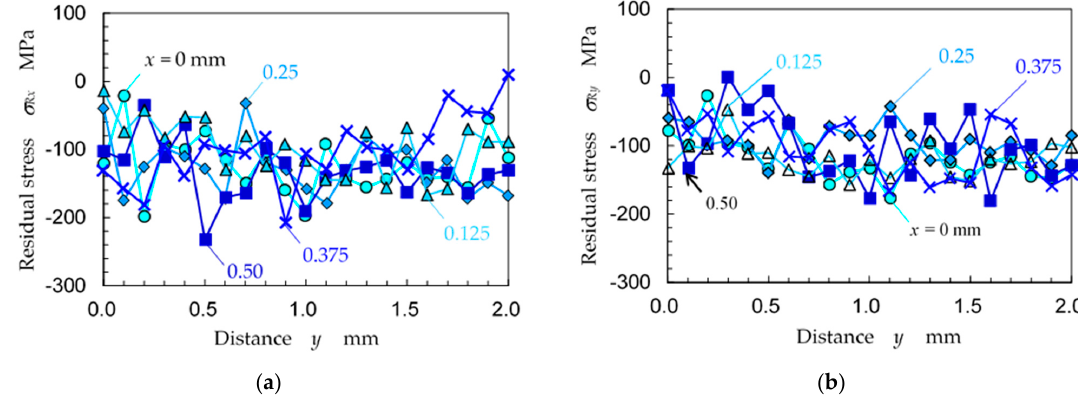
Figure 15. Aspects of the surface of the stainless-steel specimen treated by laser cavitation peening (specimen D); ( a ) ob- servation using the CCD camera on the XRD system; ( b ) observations from the laser confocal microscope.